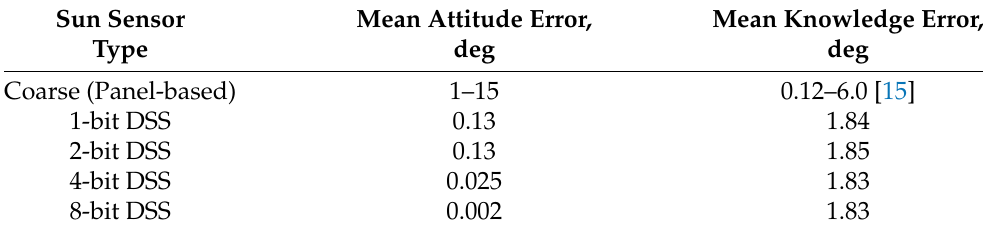
Table 6. Sun Sensor error